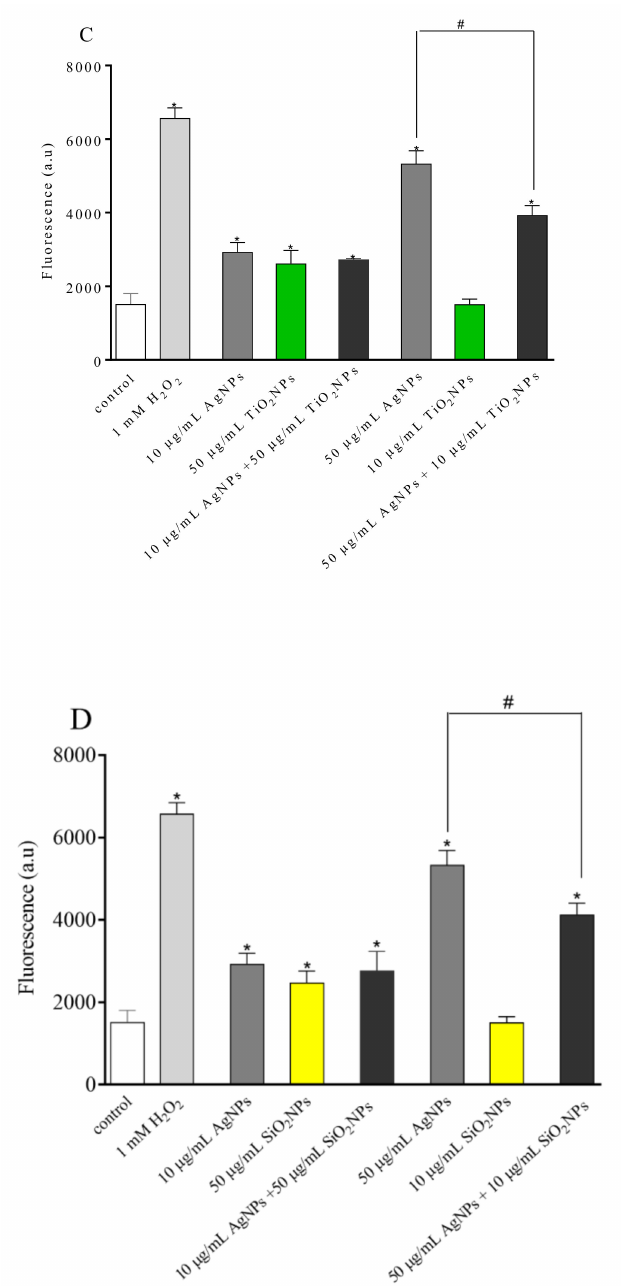
Figure 3. Generation of reactive oxygen species (ROS) in HepG2 cells treated with single NPs or the combination of AgNPs with AuNPs ( A ), CdTeQDs ( B ), TiO 2 NPs ( C ), and SiO 2 NPs ( D ). H 2 O 2 in a concentration of 1 mM served as a positive control. Mean ± SD, n = 3. * denotes a statistically significant di ff erence from the unexposed control, P < 0.05. # denotes a statistically significant di ff erence between ROS generated by the combination of NPs and the highest value observed for the single NP in this combination, P <